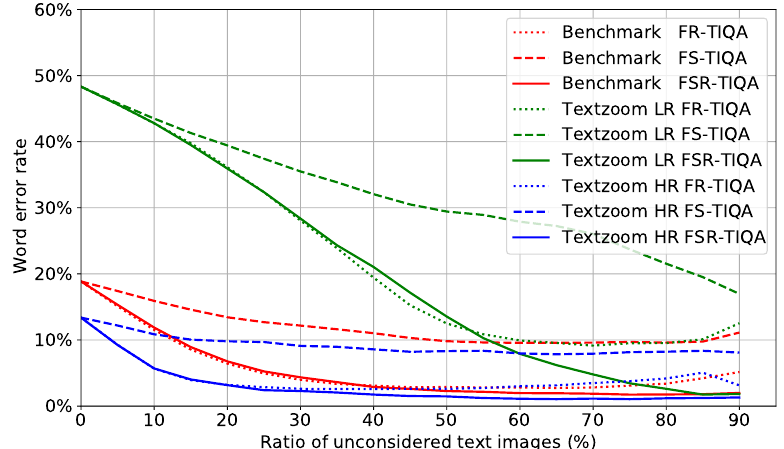
Figure 13. Text recognition performance of proposed methods on benchmark, LR, and HR datasets in Textzoom. The EVRC shows the effectiveness of rejecting low-quality text